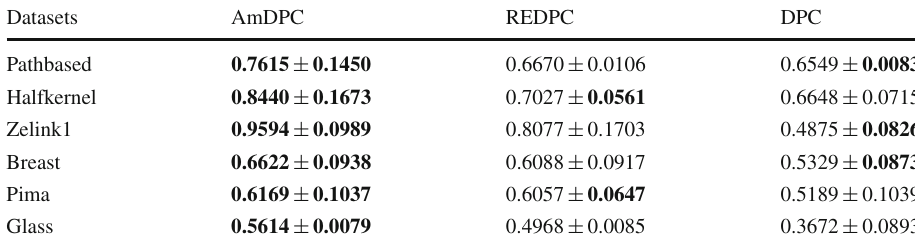
Table 10 Sensitivity analysis of FM indicator when p